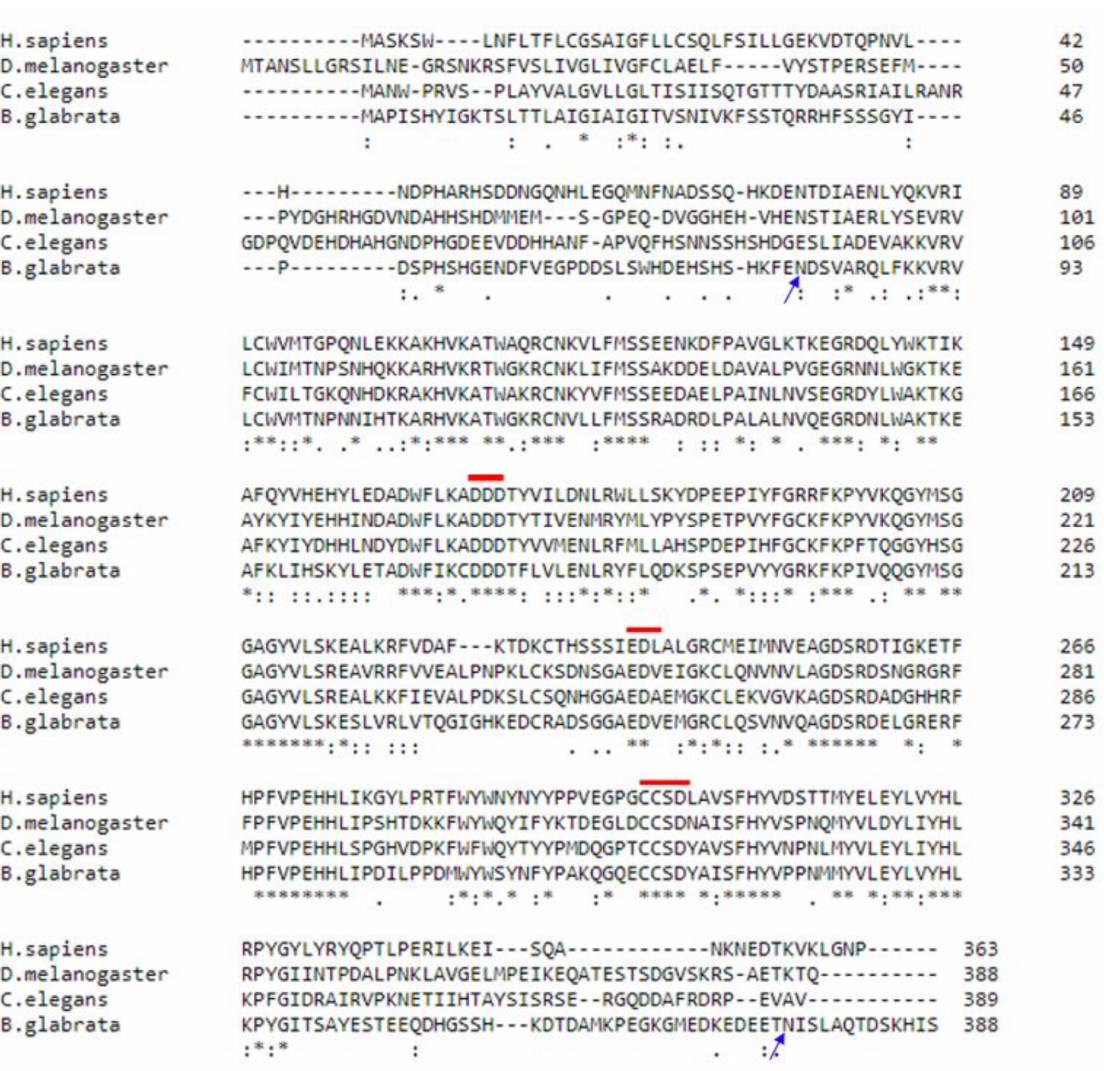
Figure 1. Comparison of the T-synthases from different species. The conserved motives are indicated by red bars and putative N-glycosylation sites are indicated by blue arrows. ( * fully conserved residues, : residues with strongly similar properties, . residues with weakly similar properties, - indicates